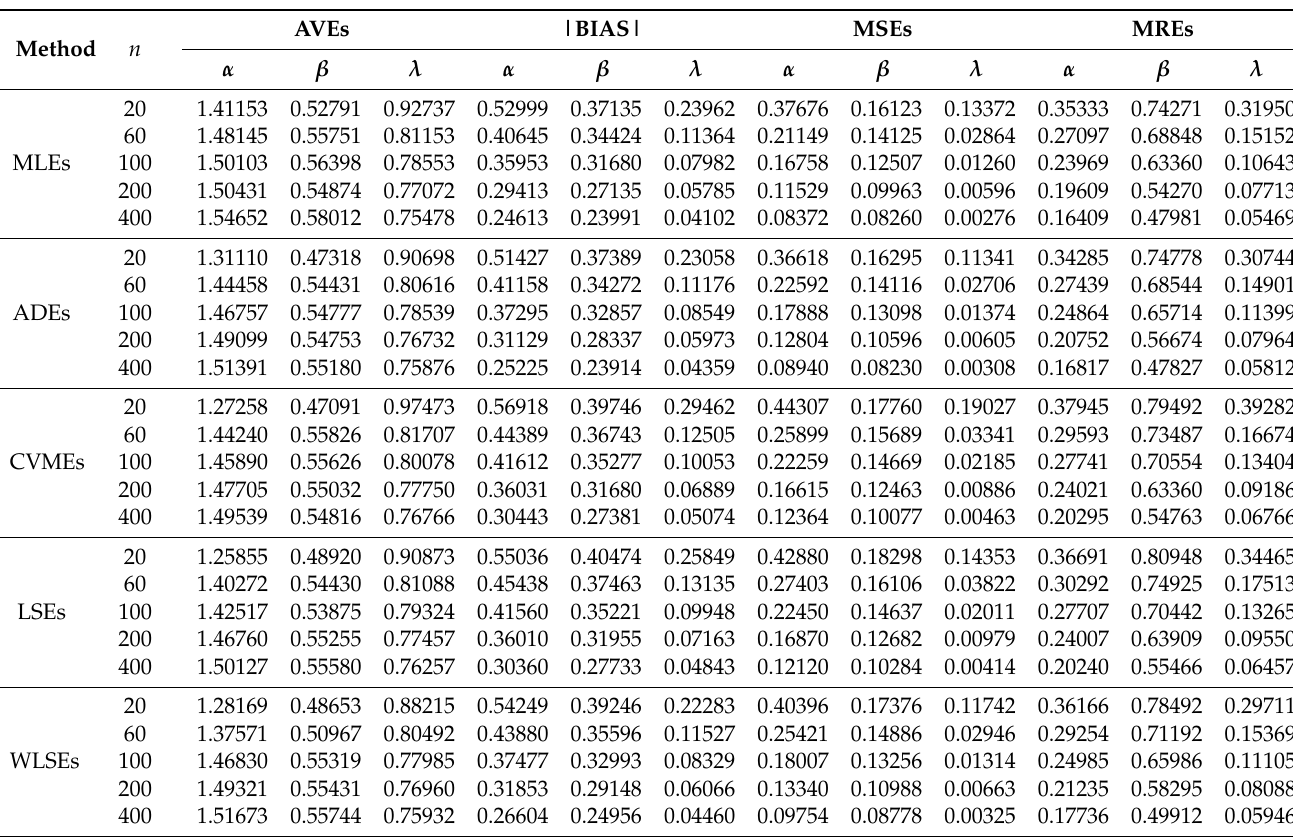
Table 3. Numerical values of the Ex-LL distribution for the parameters α = 1.5, β = 0.5, λ =